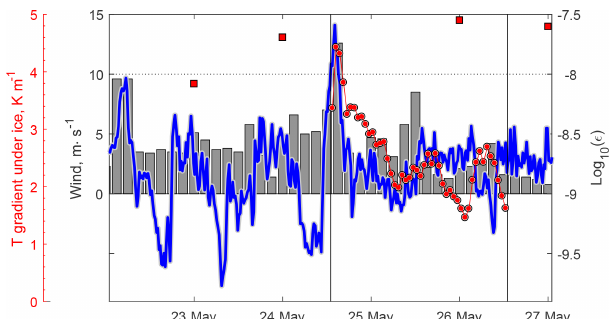
Figure 7. Vertically averaged TKE dissipation rate under ice (solid line) vs. wind speed over the lake (bars) and vertical temperature gradient from the two uppermost temperature loggers under ice, at 5 and 7cm under the ice bottom (line with symbols). Single squares show the mean daily vertical temperature gradient under ice ac- cording to the steady-state model of Barnes and Hobbie (1960); see Eq. (14). Note the different vertical axes for temperature, wind, and ε